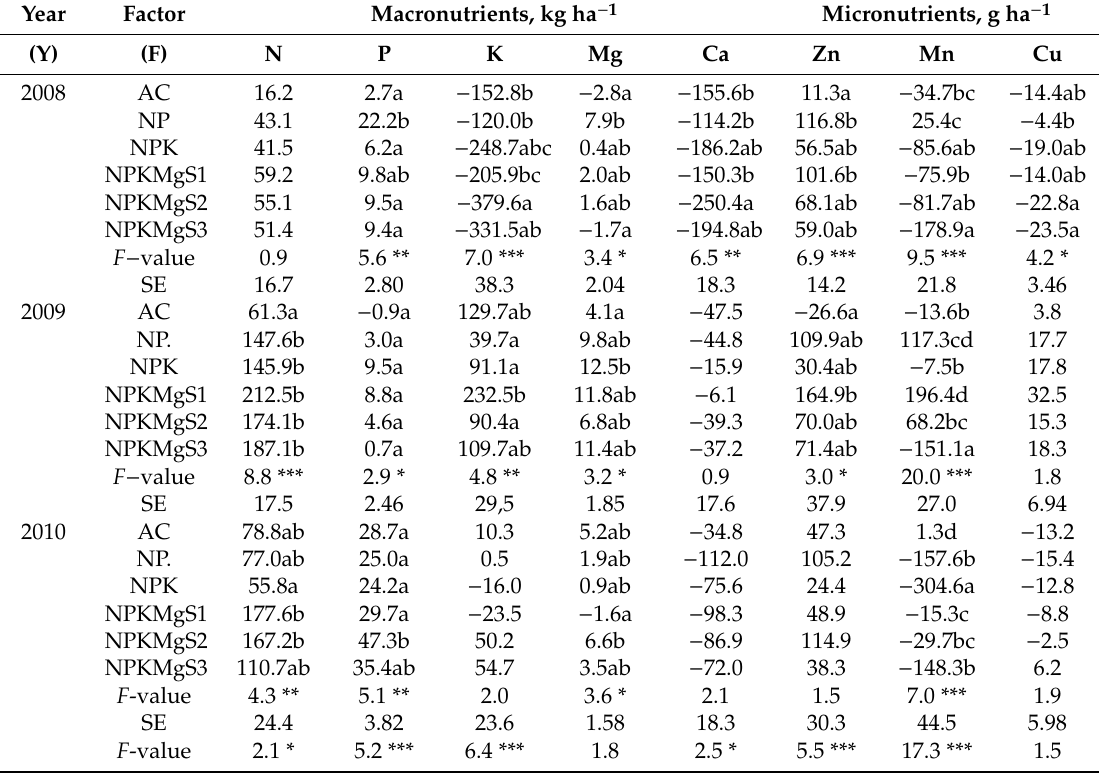
Table 7. Nutrient remobilization quota during the seed filling